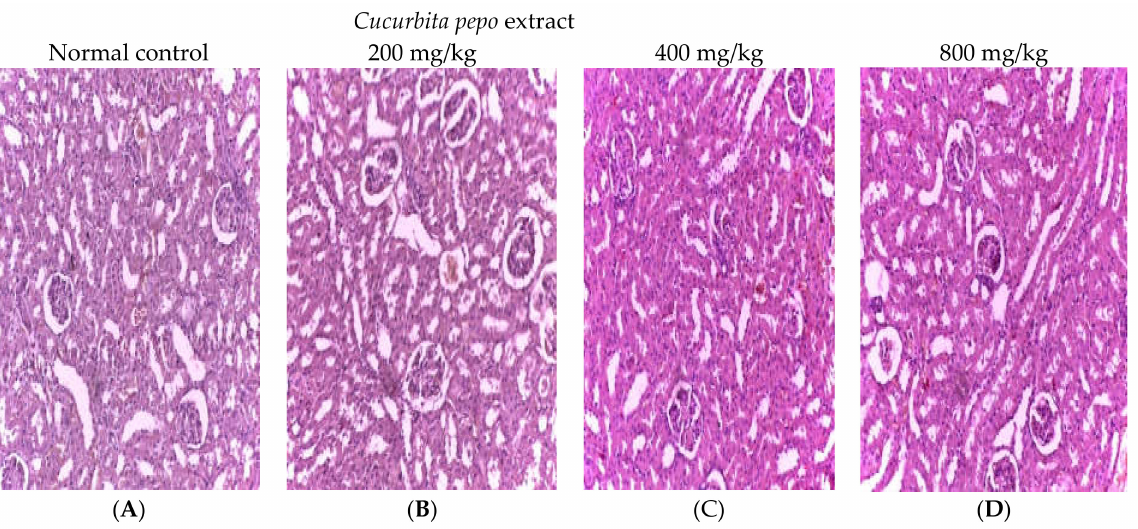
Figure 8. Micrographs of the kidney sections from untreated (control) and treated albino rats with various doses of aqueous leaf extract of C. pepo . Haematoxylin and eosin staining (H and E), magnification (400 × g ). ( A ), control; ( B ), Albino rats treated with 200 mg/kg aqueous leaf extract of C. pepo ; ( C ), Albino rats treated with 400 mg/kg aqueous leaf extract of C. pepo ; and ( D ), Albino rats treated with 800 mg/kg aqueous leaf extract of C. pepo